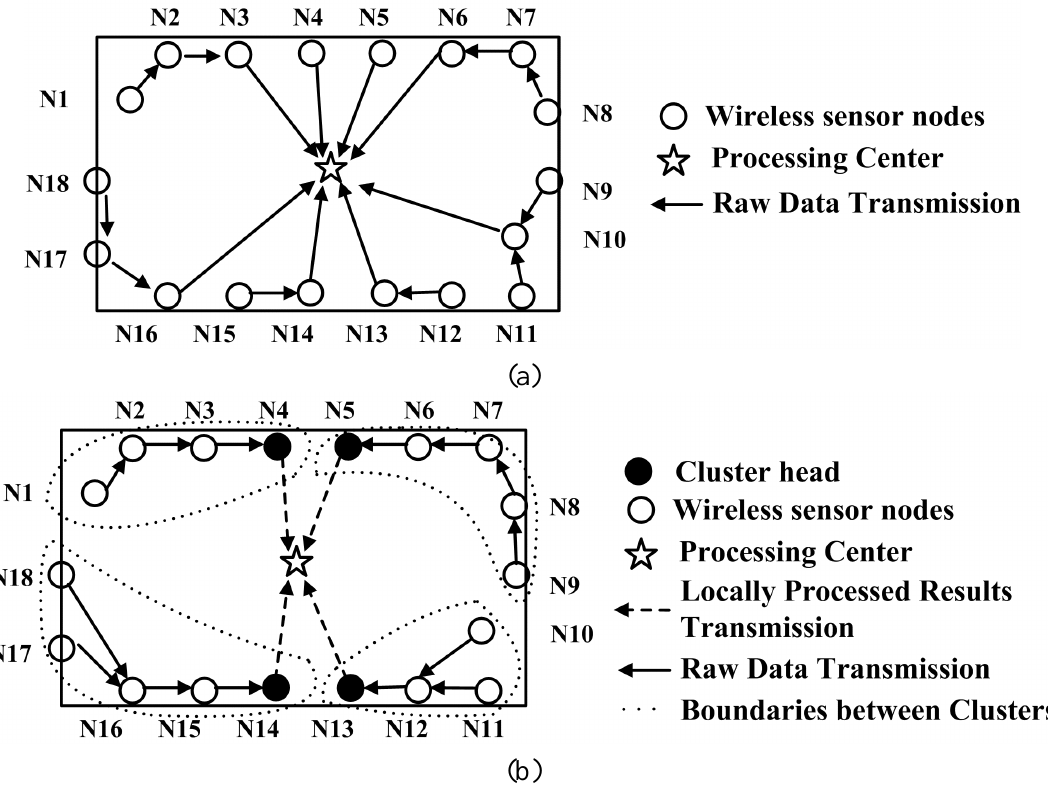
Figure 8. The setup scenario of the wireless sensor network in (a) centralized client/server framework and (b) distributed client/server